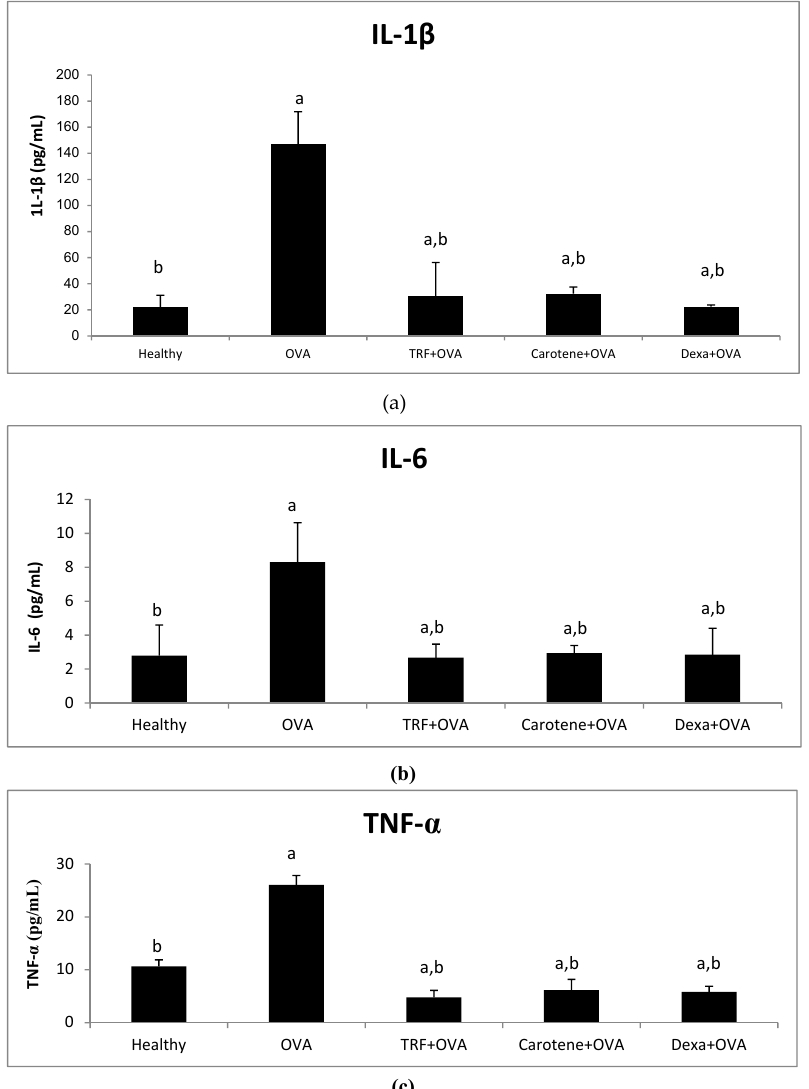
Figure 5. Effects of palm oil TRF, carotenes, and dexamethasone on pro-inflammatory cytokines, ( a ) IL-1 β , ( b ) IL-6, and ( c ) TNF- α , in the plasma of Brown Norway rats challenged with OVA. Data